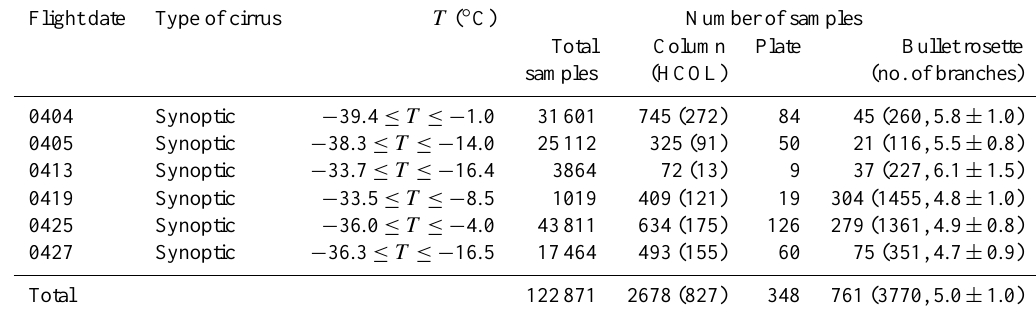
Table 6. Same as Table 4 but for